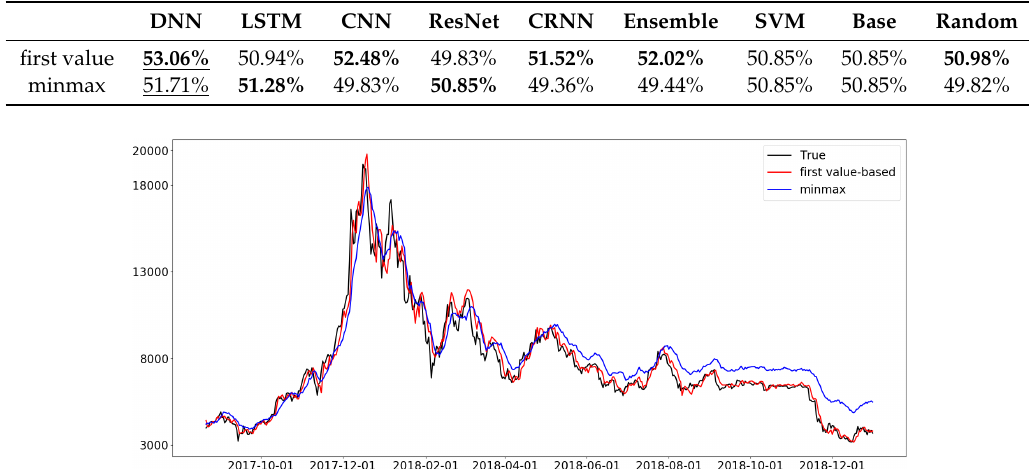
Figure 14. Prediction results of the DNN model with different normalization methods. The sequence size m = 20. The log values of the major features and the sequential partitioning were